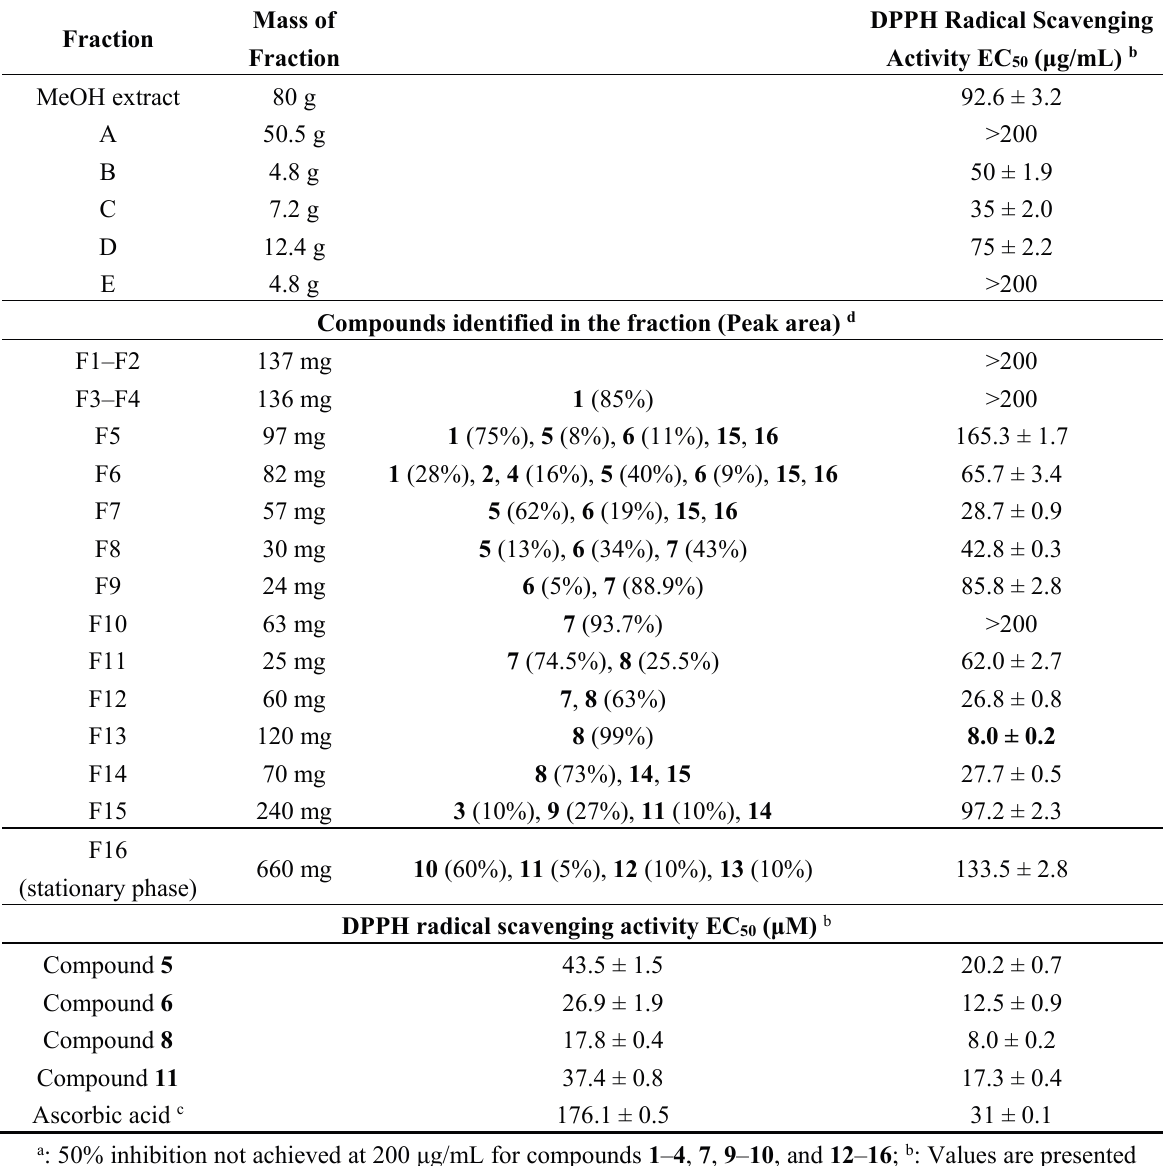
Table 1. DPPH radical scavenging activities of MeOH extract, fractions, and compounds isolated from S. varia a